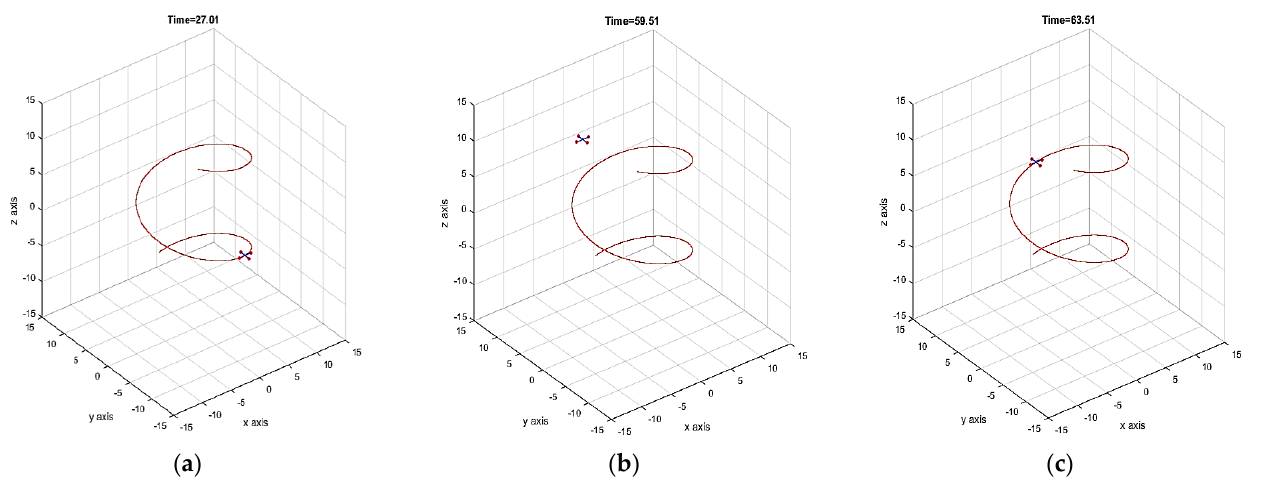
Figure 12. Quadrotor following helical trajectory using F-SMC control design.